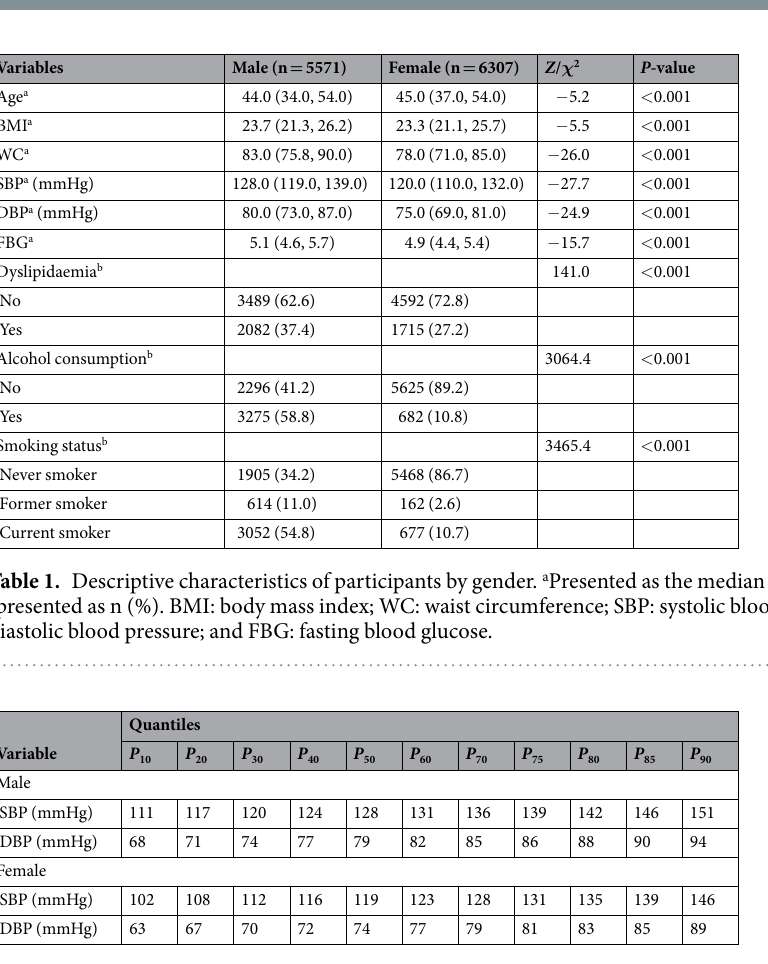
Table 2. Quantiles of blood pressure (SBP & DBP) by gender. Numbers in the Table are blood pressure in different